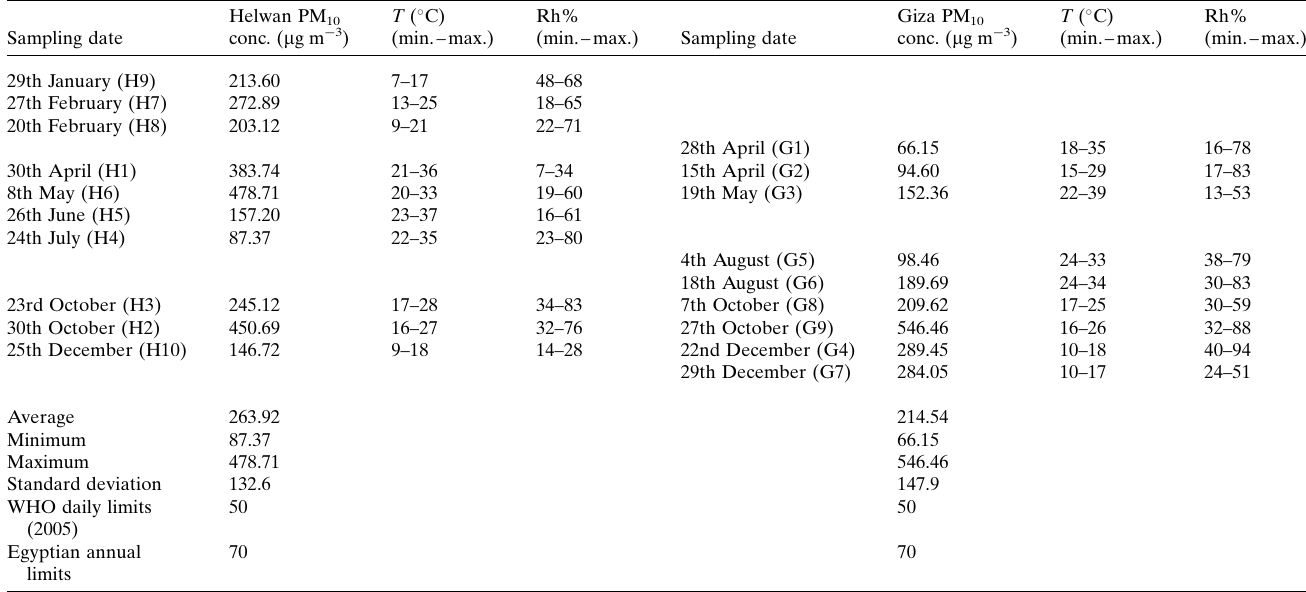
Table 1 Concentrations of PM 10 in ambient air over Helwan University and Giza Square sampling sites in 2018, with indication of the temperature range and relative humidity